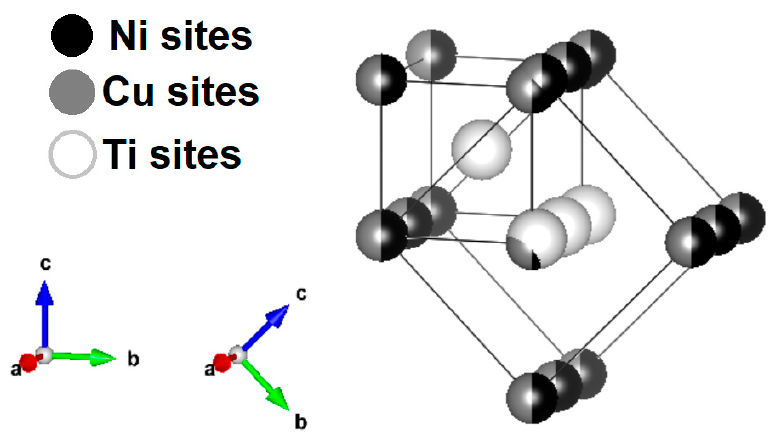
Figure 7. B2 and B19 phase crystal structures.